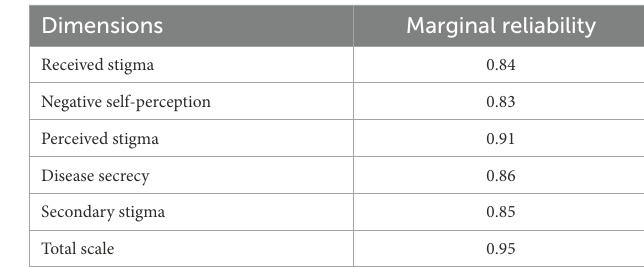
TABLE 6 Marginal reliability of each dimension and total